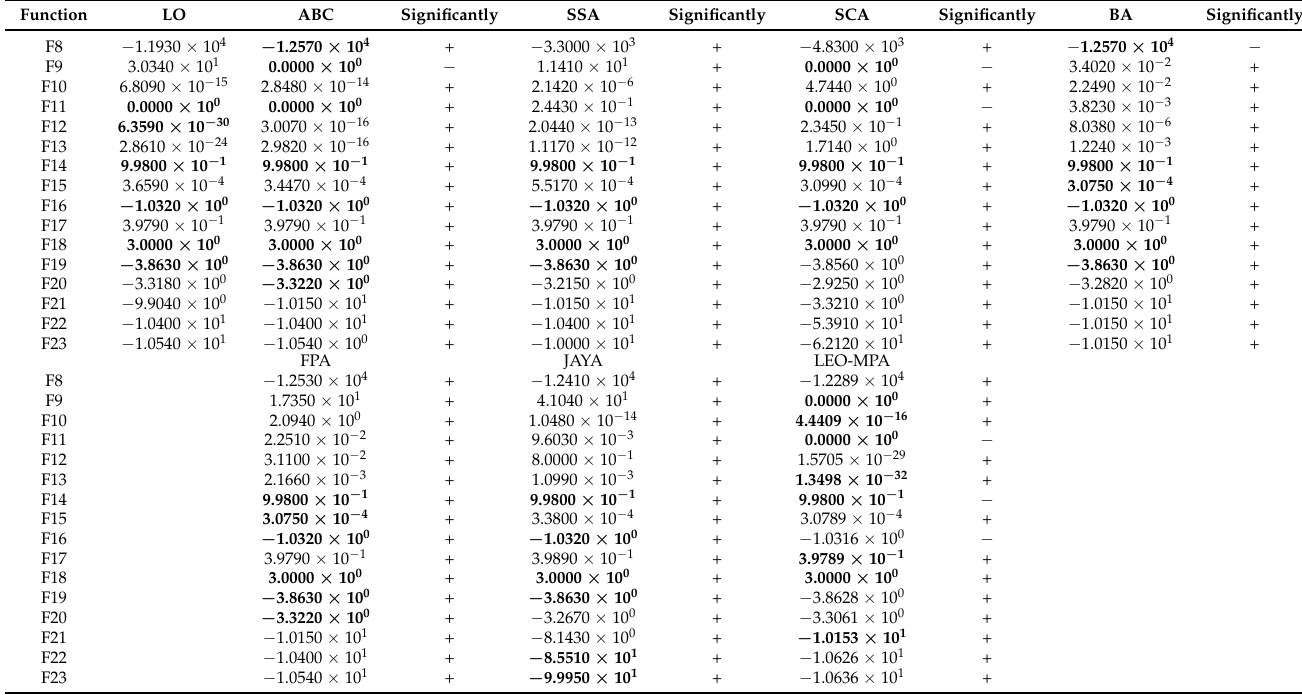
Table 6. Comparative performance of the LO algorithm with swarm algorithms based on functions F8–F23.